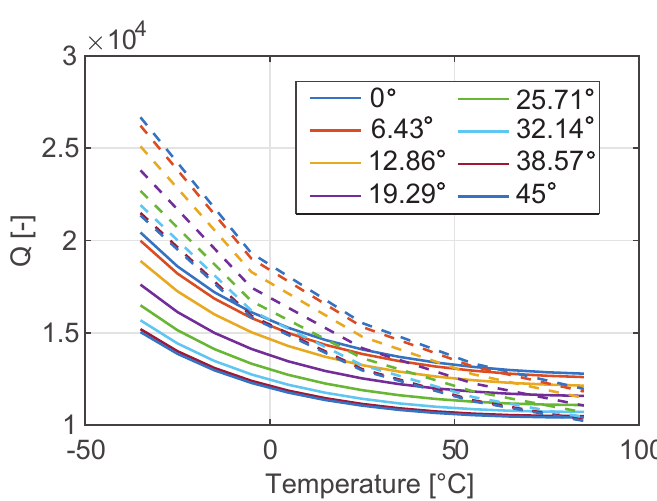
Figure 8. Temperature variation of the quality factor of the tuning fork in the range [ − 35 ◦ C–85 ◦ C] for different orientations of the device with respect to the silicon wafer. Dotted lines denote numerical results, while continuous lines represent the analytical solution shown in Figure 6.